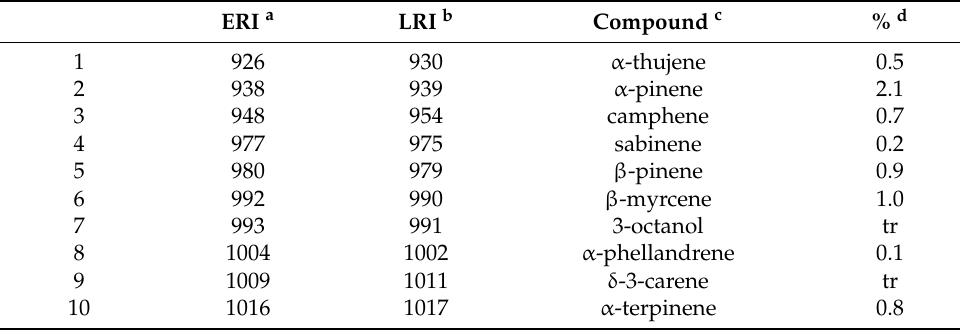
Table 1. Chemical composition of essential oil of T. vulgaris